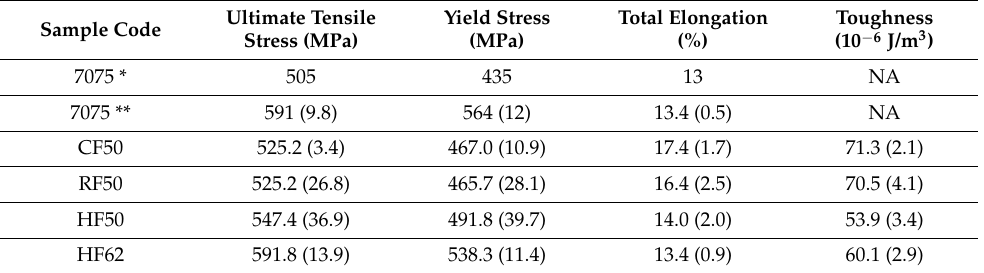
Table 2. Measured Tensile Strength (UTS, YS, and total elongation TEL) for Different Samples after T73 Treatment (listed values are the average of four tests).